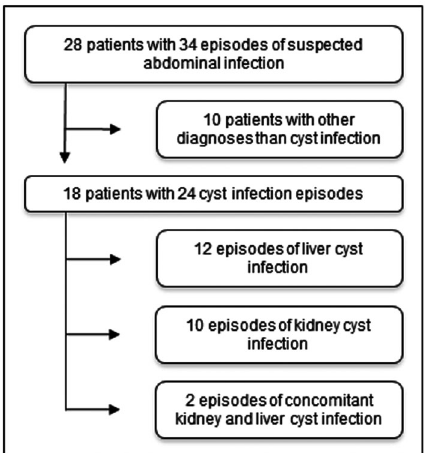
Figure 1. Retrospective cohort of hospital-admitted autosomal dominant polycystic kidney disease